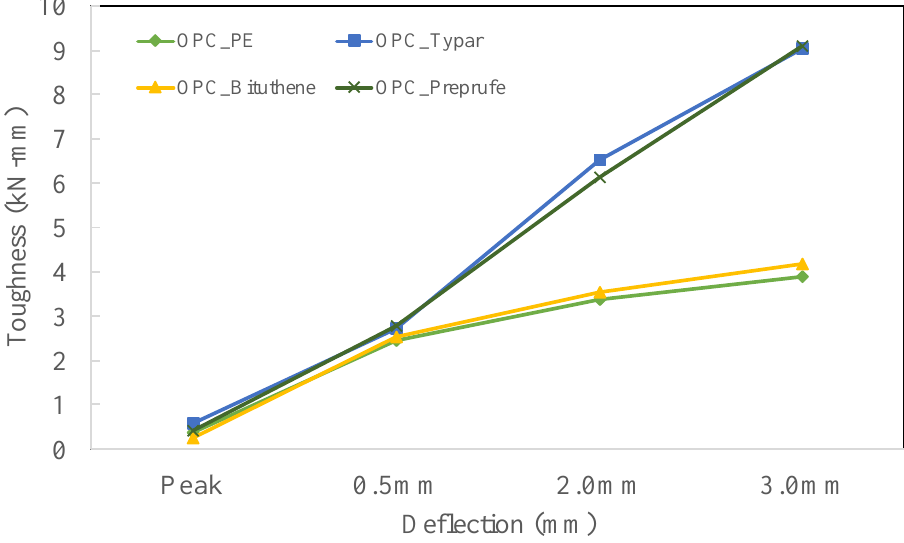
Figure 8. Toughness improvement with different types of waterproofing reinforcement.